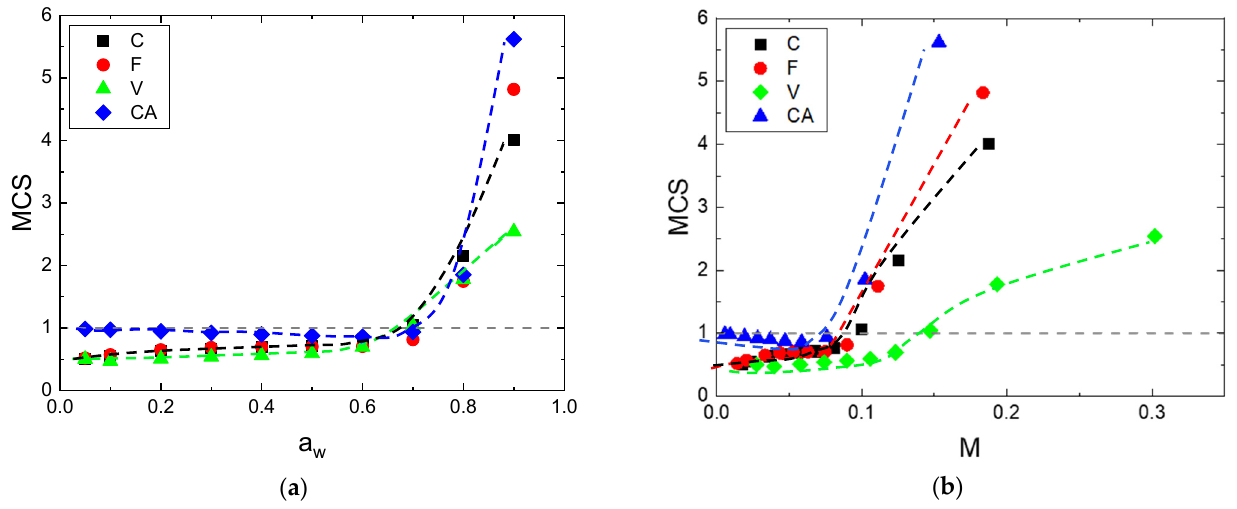
Figure 8. Evolution of MCS as a function of: ( a ) the water activity and ( b ) the water mass gain .